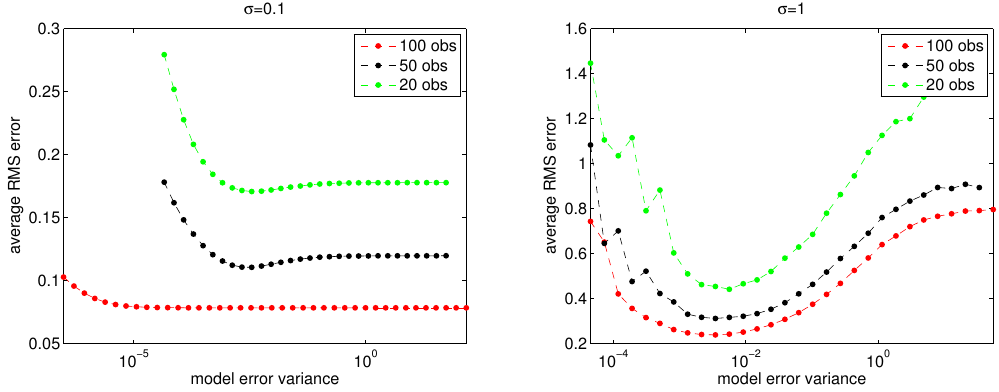
Figure 3. Model error variances λ vs. average rms errors of the state estimates with a varying number of observations and observation errors σ y = 0.1 (left panel) and σ y = 1 (right panel). Figure 3: Model error variances λ vs. average RMS errors of the state estimates with varying number of observations and observation errors σ y = 0 . 1 (left) and σ y = 1 (right). 203